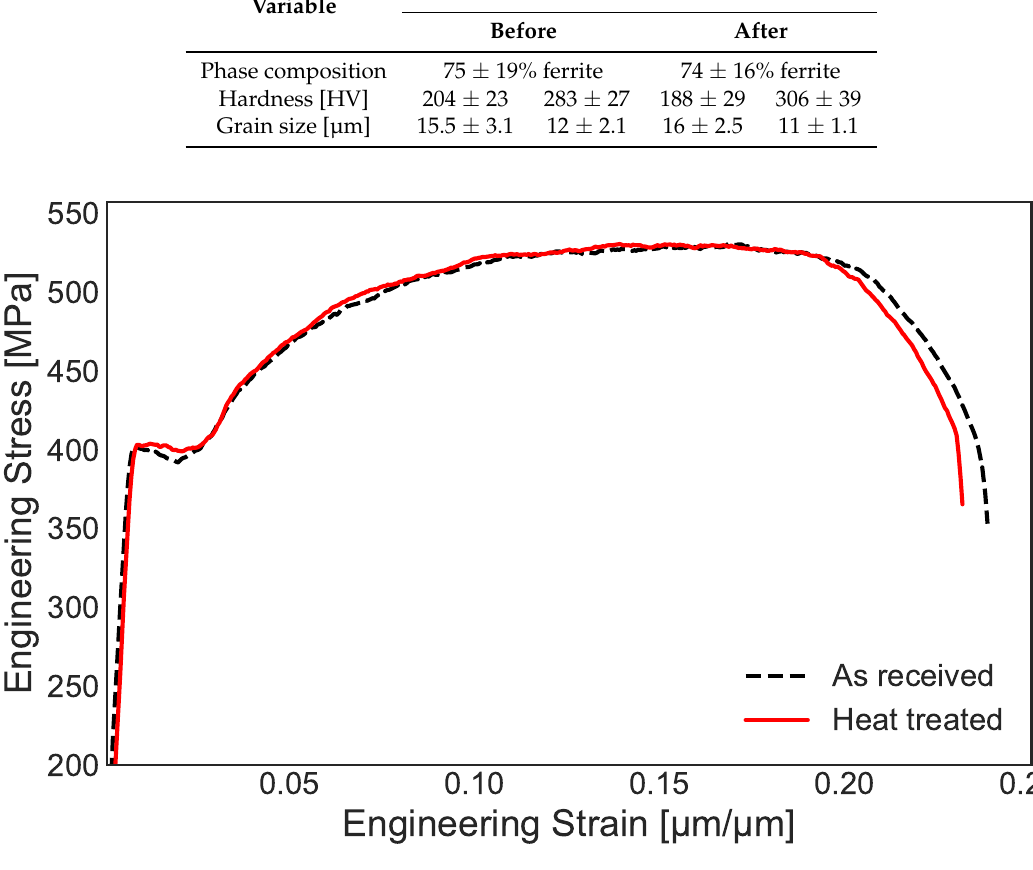
Figure 17. The tensile test curve of the heat treated and as received